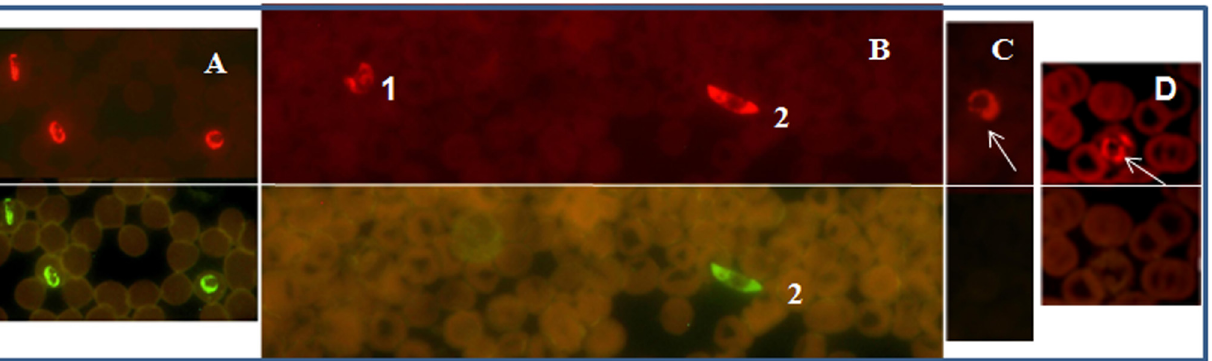
Fig 2. Blood smears tested with P . falciparum FISH assay. Malaria positive patient blood samples from two collection sites, Peru (A), and Kenya (B) were analyzed using PF-FISH assay. (A) Patient blood positive for P . falciparum . (B) Patient blood positive for P . malariae [1] and P . falciparum gametocyte [2]. (C) Patient blood positive for P . ovale . (D) Patient blood positive for P . vivax . Green fluorescence is due to the P . falciparum specific probe and red fluorescence due to the Plasmodium genus probe.